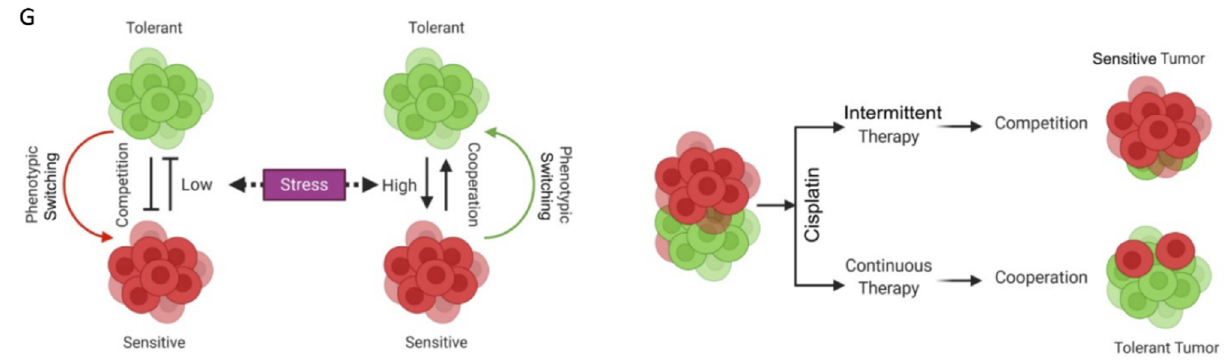
Figure 5. Mathematical model for cisplatin resistance. ( A ) Schematic demonstration of AUC and cellular death rate as function of AUC ; ( B , C ) fitting of the experimental growth data where the cells were co-cultured for three weeks; ( B ): sensitive cells; ( C ): tolerant cells; circles and lines repre- sent the experimental and fitted trends respectively; ( D ) SCALE parameter as measure of cisplatin sensitivity for the sensitive and the tolerant cells; the error bars represent 95% confidence limits ( E , F ) simulation of intermittent and continuous cisplatin treatment according to the protocols de- scribed in Figure 3; the initial sensitive to tolerant cell ratio was set to 4:1 with a total cell population of 50,000. ( G ) An illustrative model depicting the presence (and absence) of group behavior among sensitive and tolerant cells under varying conditions of stress and effects of continuous versus intermittent